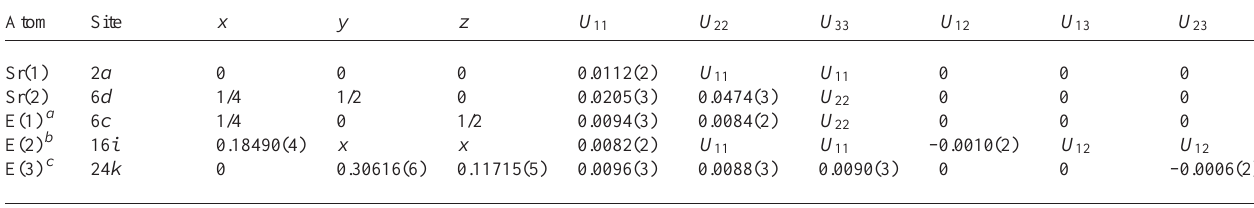
Table 4. Atomic coordinates and displacement parameters (in Å 2 ) .